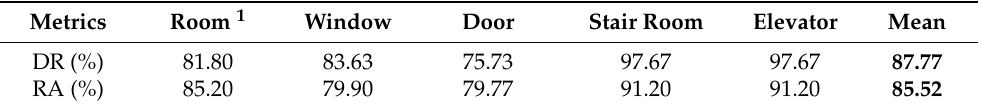
Table 3. Indoor model result.